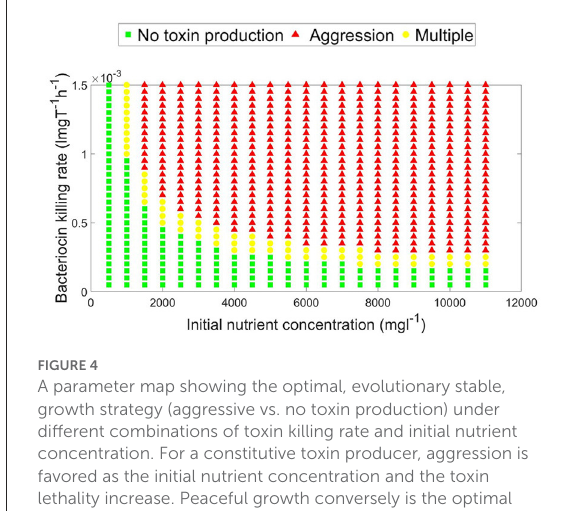
FIGURE5 While the spatial mode of growth significantly reduce the cost endured in the mutual aggression scenario due to the resulting spatial segregation, the outcomes of other scenarios are not significantly altered from the well-mixed growth setting. (A) No aggression: competition between two non toxin producers in the biofilm mode of growth. Starting from an initial mixed layer of cells, the two strains grow together to form a mixed biofilm with little linage segregation. (B) Asymmetric aggression: competition between a toxin producing strain (red) and a non toxin producing strain (blue), in spatial settings. The constitutive toxin producer come to dominate the competition at early stage, leading to the elimination of the non toxin producing